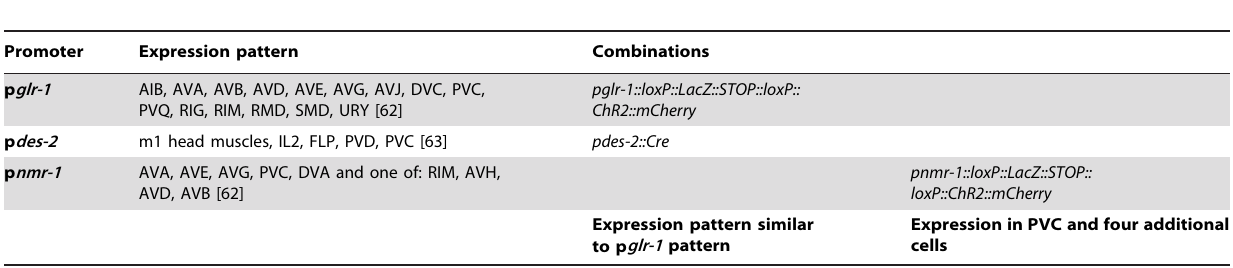
Table 1. Promoter combinations used for PVC specific ChR2 expression (Cre-lox system).